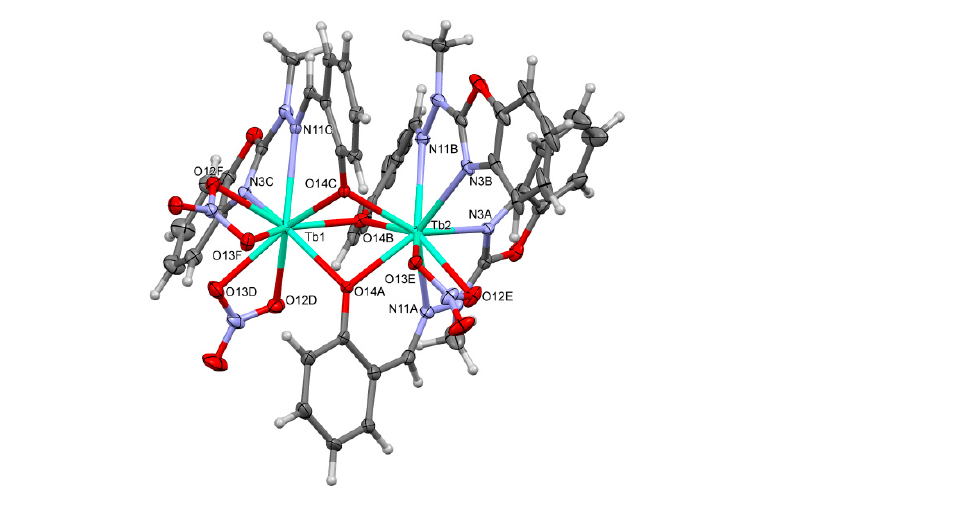
Figure 1. A perspective view of the Schiff base ligand HL . Ellipsoids are drawn at the 50% probability level, hydrogen atoms are represented by spheres of arbitrary radii, blue dashed line denotes the intramolecular hydrogen bond. Hydrogen atom has been localized on the basis of difference Fourier map (Figure S2) and successfully refined.